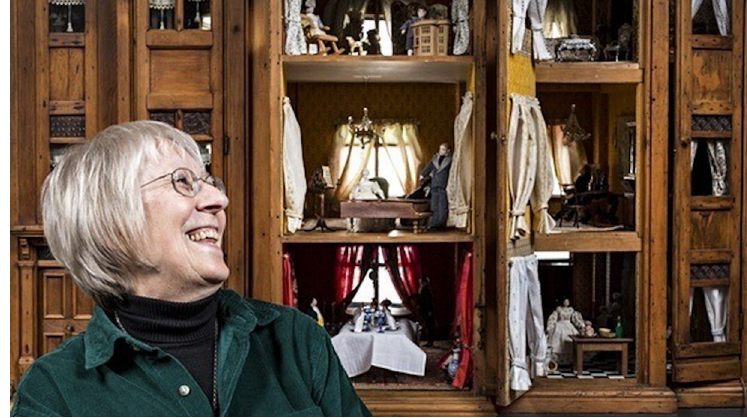
Figure 1.2 Susanna Pinney with Betty Pinney’s doll’s house. Photograph: David Levene for The Guardian , 6 December